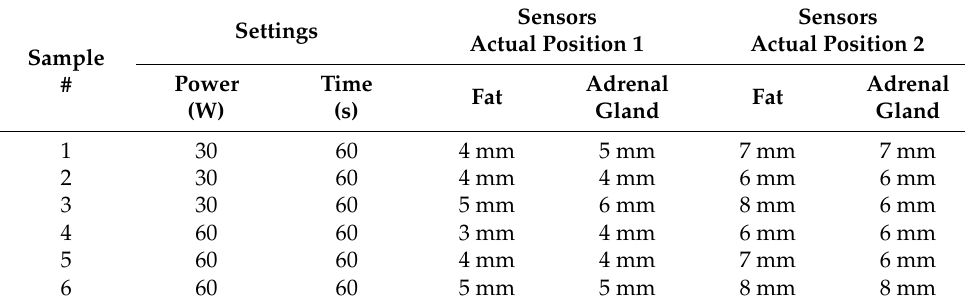
Table 2. Summary of the power and time settings and of actual positions of the fiber optic sensors with reference to the feed of the antenna for each MWA experimental procedure. The original positions of the sensors were 4 mm and 7 mm along the radial distance from the axis of the applicator both in the adrenal tissue and surrounding fat.